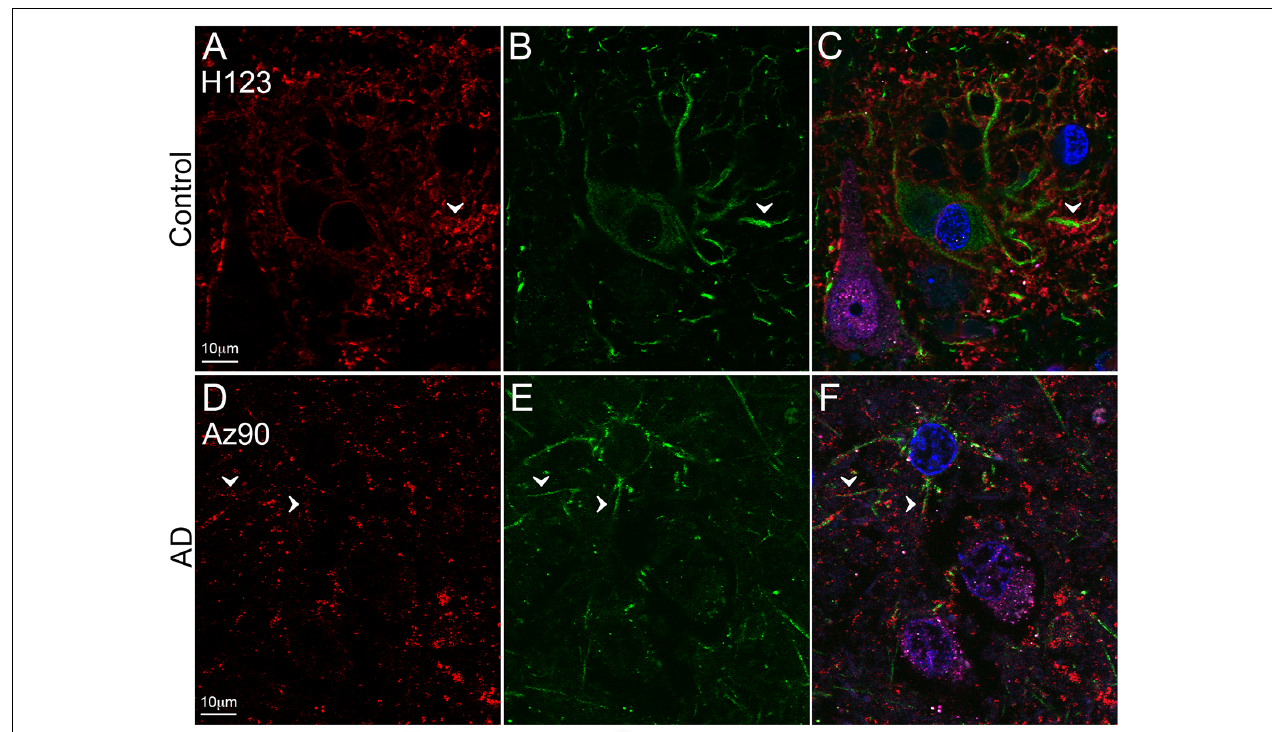
FIGURE 5 | EAAT2 expression in the superior temporal gyrus (STG). Photomicrographs of layer III of the STG showing EAAT2 ( A,D , red), GFAP ( B,E , green), and EAAT2 overlaid with GFAP and NeuN (magenta; C,F ) immunoreactivity for a representative control ( A–C , H123) and Alzheimer’s disease (AD) ( D–F , Az90) case. In controls, EAAT2 labeling is more localized to membranes of astrocytic stem processes, while in AD the staining is weaker on astrocytic main branches ( A–F , arrowheads), but more labeling is likely localized to fine astrocytic branches in the neuropil. Cell nuclei are labeled with Hoechst nuclei counterstain ( C,F , blue). Scale bar (A–F) = 10 µ